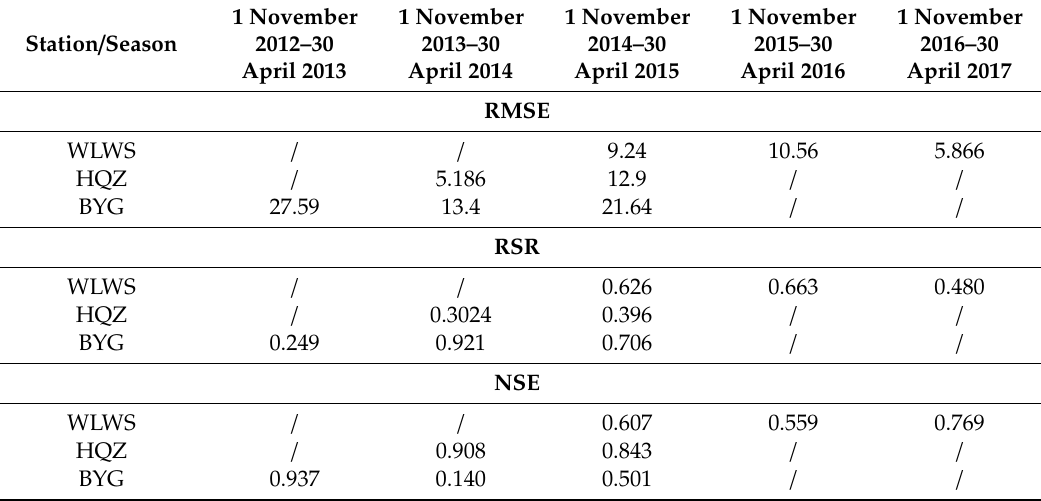
Figure 3. SWE simulated by the Utah energy balance (UEB) model (red line) for a single 3-hour time step compared with the observations (black line) at the three automatic snow stations for the 2012–2017 effective snowmelt periods. Table 4. Model error statistics at the three automatic snow stations.